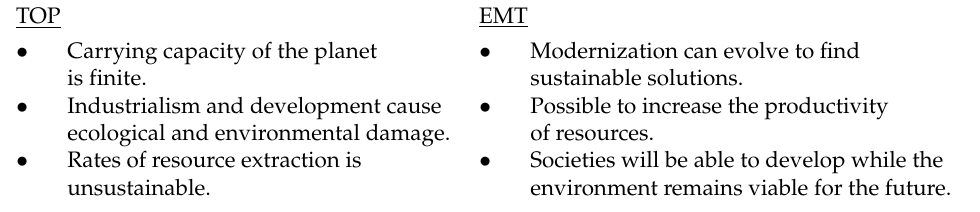
Table 1. Key Points of the TOP–EMT